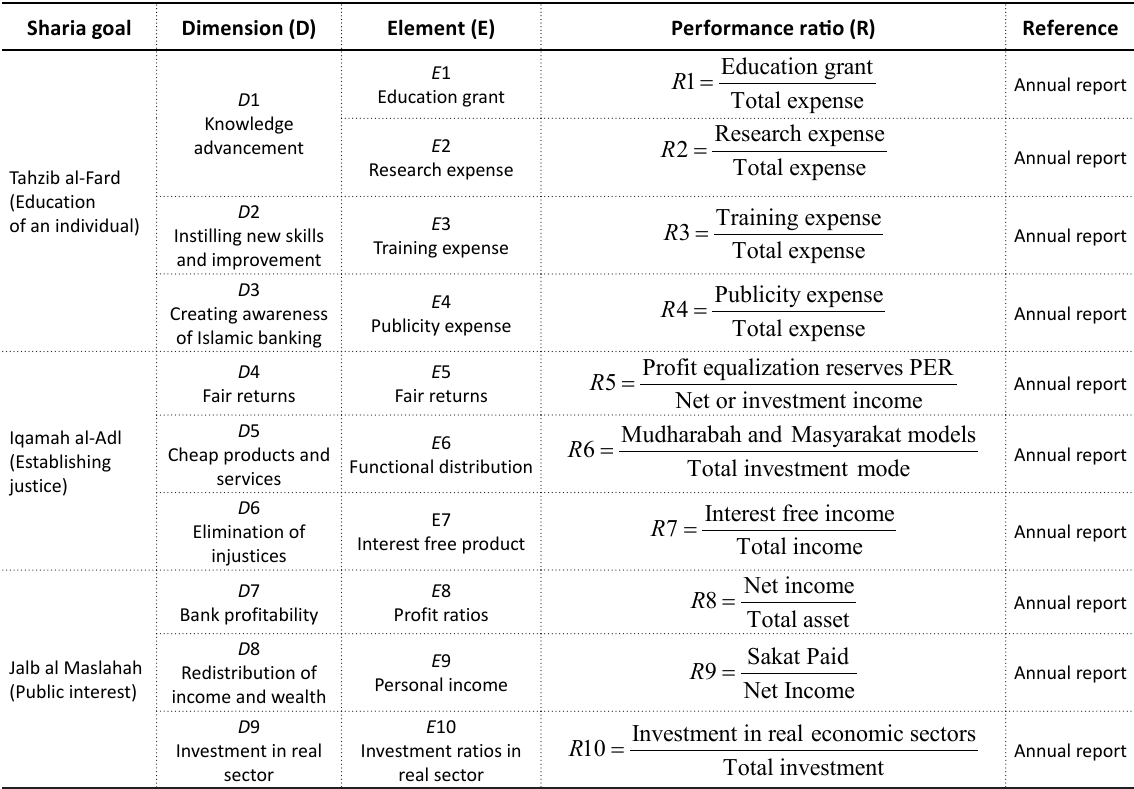
Table 1. Evaluation of the Maqashid sharia index